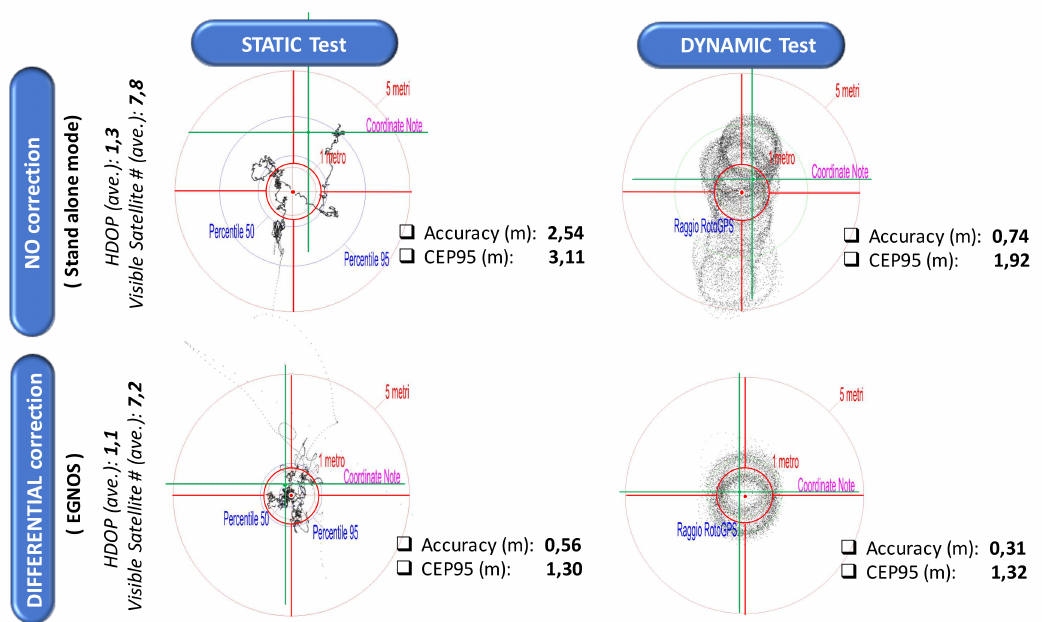
Figure 9. Examples of static and dynamic tests simultaneously carried out with the device described in Figure 8. The tested receiver is a good performance model that can be used both in a stand-alone mode and with a real-time EGNOS di ff erential correction. The green cross axes indicate the actual position of the measuring system, previously geolocalized with extreme accuracy. The red cross axes (with the central circle indicating the expected trajectory of the rotating arm, here 1.2 m long) refer to the medium performances around the centroid of the overall fixings (10800, after 3-h test). CEP95: radius of the Circle Error Probable, where 95% of the fixings would fall in; HDOP: Horizontal Dilution Of